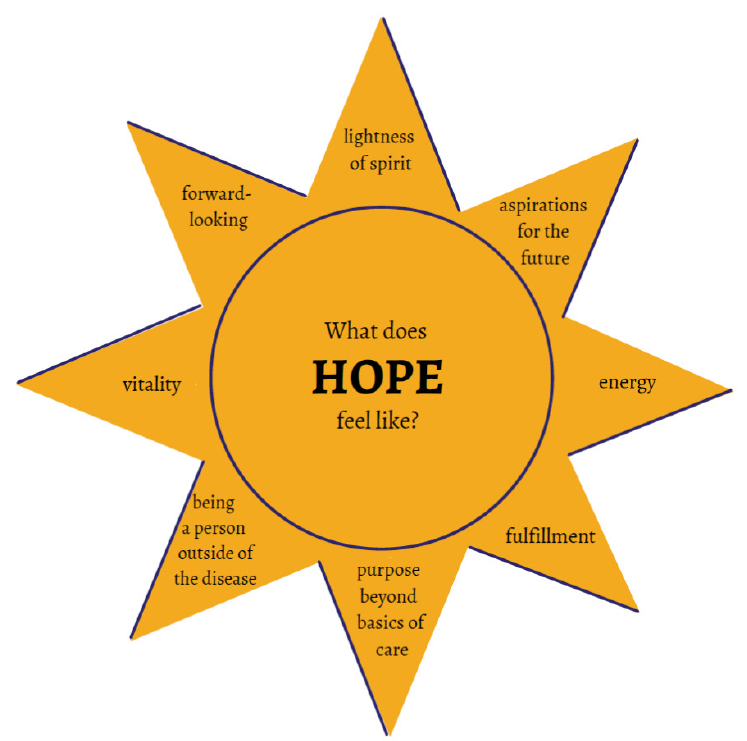
Figure 1. What does HOPE feel like? This patient and family-generated graphic depicts what hope feels like to them. This conceptualization of the attributes of hope can be used to guide the selec- tion of outcome measures for future research studies aimed at improving